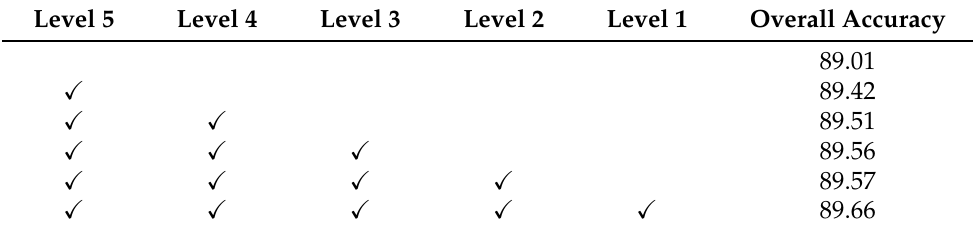
Table 3. Ablations for the different level feature maps on ISPRS Vaihingen